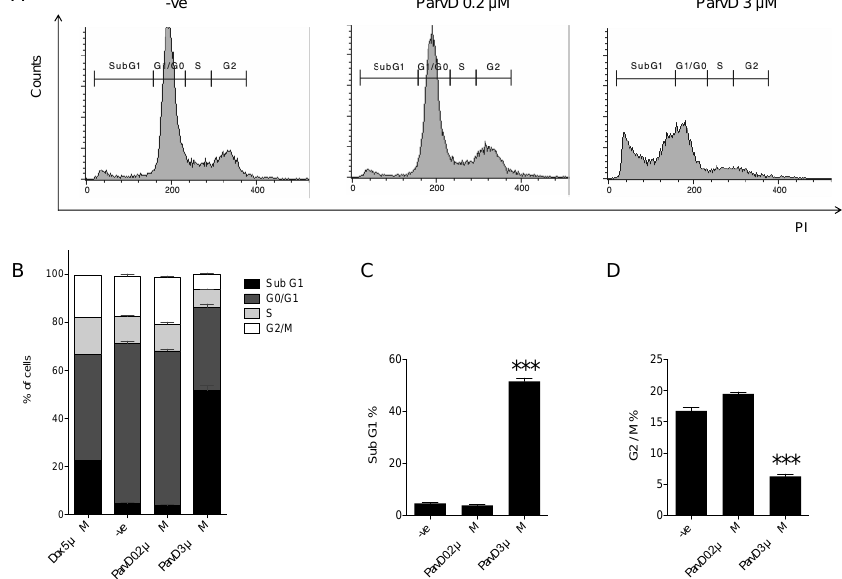
Figure 4. ParvD induces an increase in Sub-G 1 and a reduction of G 2 / M populations. MDA-MB-231 cells were treated with the indicated concentrations of ParvD for 48 h. Dox 5 µ M was used as a positive control. Cells were fixed, permeabilized, and stained with PI. ( A ) Cellular DNA content was analyzed by flow cytometry, representative histograms are shown. ( B – D ) Cell Sub-G 1 , G 0 / G 1 , S, and G 2 / M population summary results (Means ± SEM). *** p < 0.001 (Student’s t -test, relative to untreated cells).